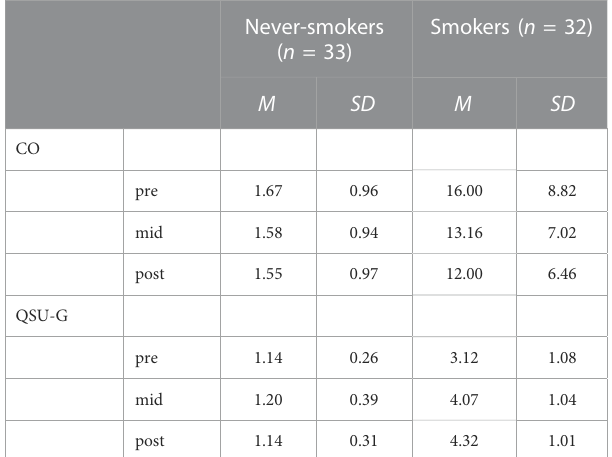
TABLE2Mean(SD)ofalveolarcarbonmonoxide levelsCO(ppm)andscores on the Questionnaire of Smoking Urges (QSU-G) in never-smokers and smokers before the start of the experiment (pre), during the break after the fi rst block of the experiment (mid) and at the end of the experiment (post).